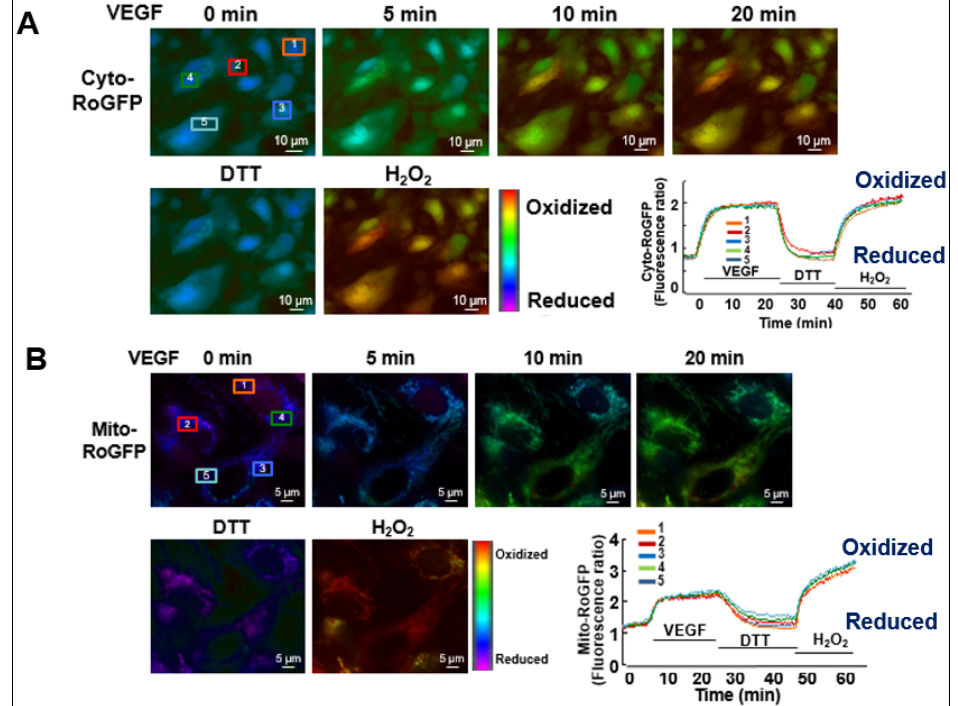
Figure 4. Real ‐ time imaging for cytosolic and mitochondrial redox status in single cell in response to VGEF.